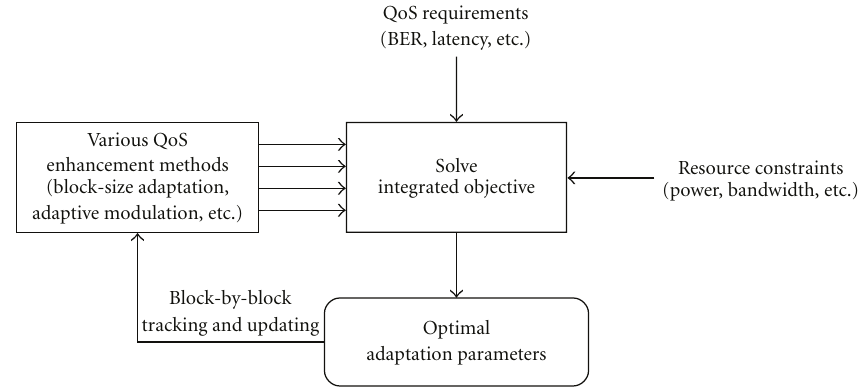
Figure 2: The conceptual framework of block-by-block